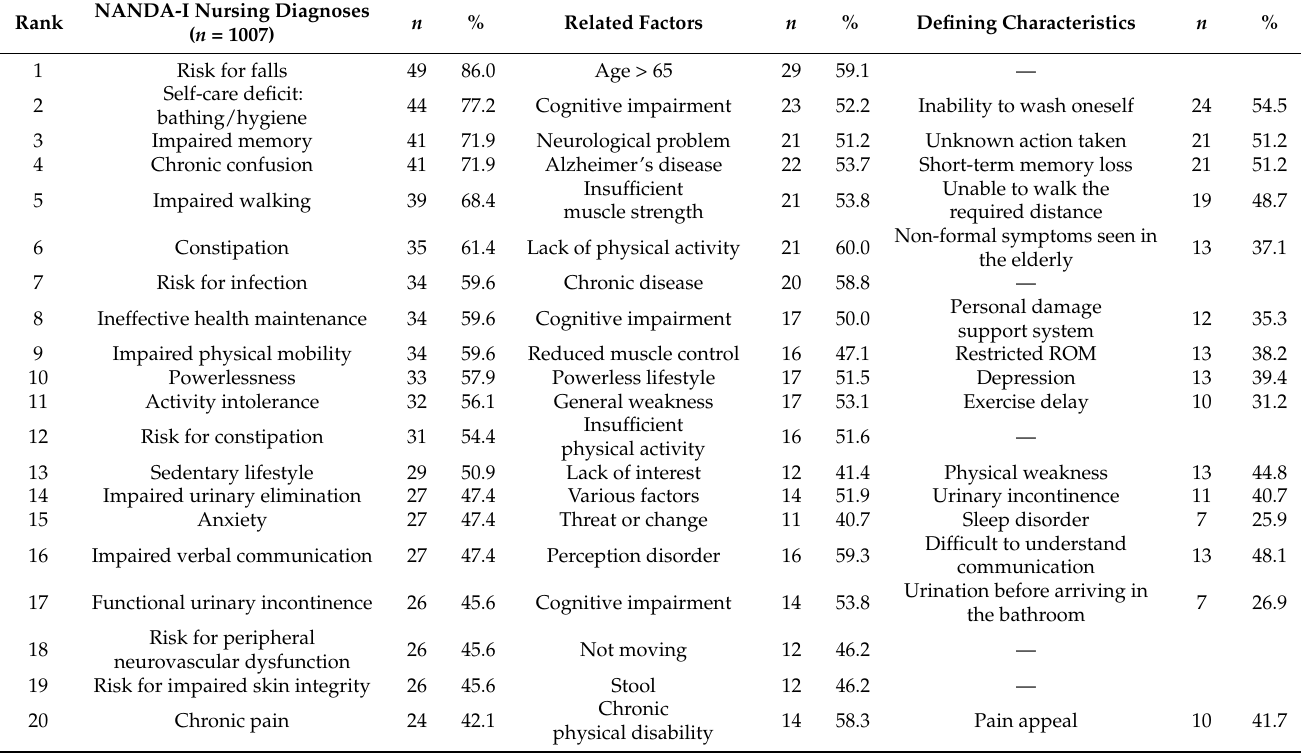
Table 2. Frequency of Top 30 NANDA-I nursing diagnoses, related factors, and defining